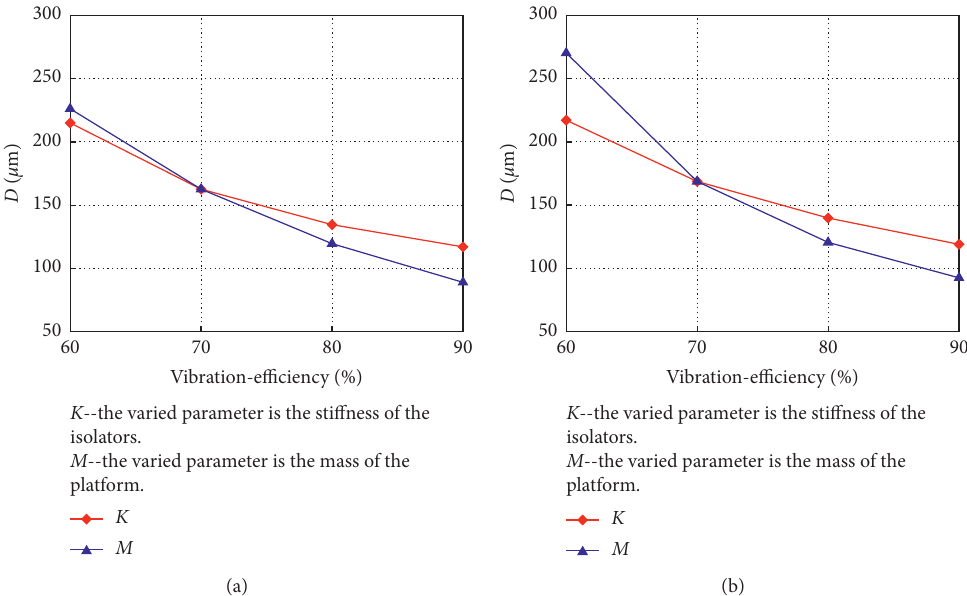
Figure 7: Vibration displacements of each point under each vibration-isolation efficiency. (a) PT4X and (b) Table 9: Ratio of vibration displacement of point to reference value at each vibration-isolation efficiency. Varying parameter